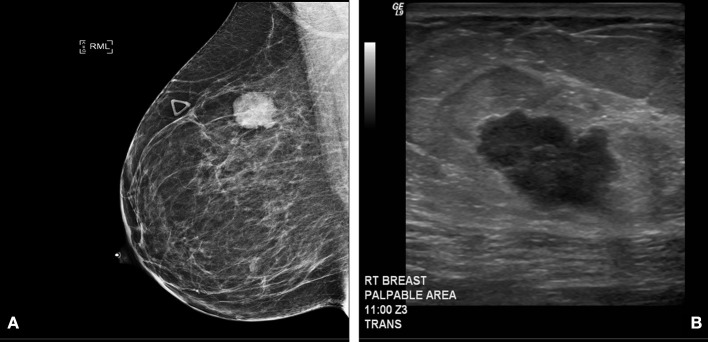
(A) Diagnostic Mammogram: Right medio-lateral oblique view showing an irregular high density mass in the superior central aspect of the right breast. (B) Ultrasonography of right breast and axilla: Irregular hypoechoic macro-lobulated mass in the superior central aspect of the right breast.